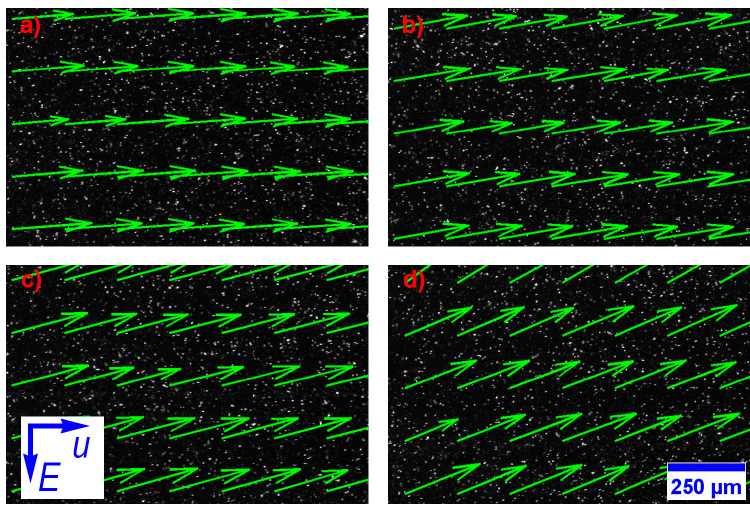
Figure 2. Graphical representation of the PIVlab results. All with 10 6 bacteria per milliliter in LB media at a hydrodynamic flow u of 1 μ L/min. The applied electric field E is increased from 10 V/cm ( a ) over 20 V/cm ( b ) and 30 V/cm ( c ) to 40 V/cm ( d ). The white dots are bacteria in contrast to the black background.